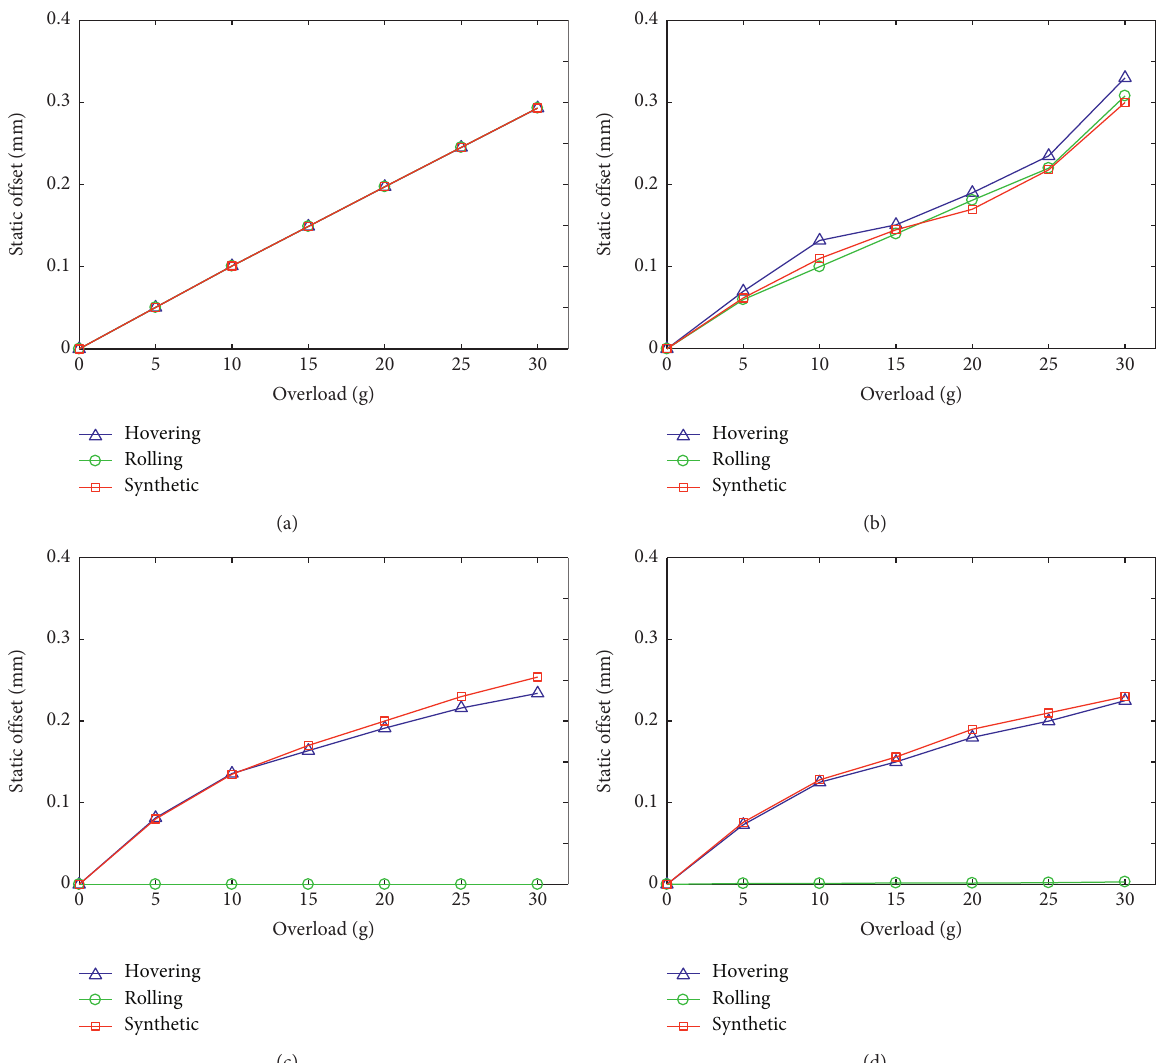
Figure 11: Variation result of the static displacements of disk 3 with overload under maneuver flight conditions. (a) Horizontal magnitude, numerical simulation. (b) Horizontal magnitude, experimental results. (c) Vertical magnitude, numerical simulation. (d) Vertical mag- nitude, experimental results.